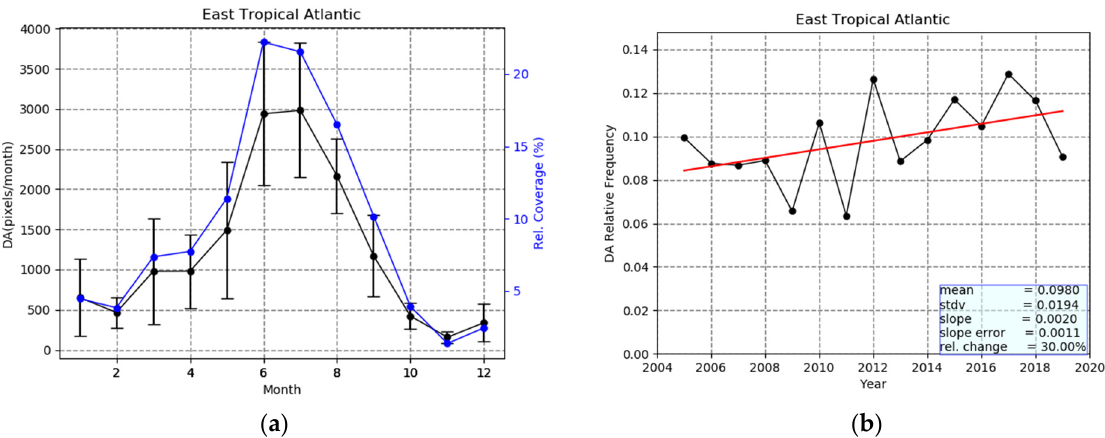
Figure 9. ( a ) Intra-annual variability of the 2005–2019 averages of the total absolute number of grid cells (1° × 1°) where dust aerosols (DA) were detected over East Tropical Atlantic by the satellite algorithm (left axis) and the percent coverage of the region by dusty grid cells (right axis). The error bars represent the year-by-year variability by means of computed 2005–2019 standard deviations. ( b ) Inter-annual variability and linear trend of the relative frequency of dust aerosols (DA) over East Tropical Atlantic.